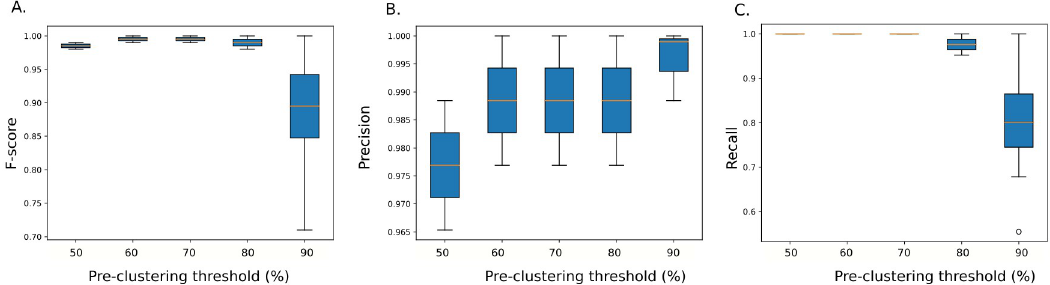
Fig 4. Effect of pre-clustering threshold on MobiLLe’s performance. The pre-clustering threshold varied from 50% to 90%. We computed the closeness F-score (A), precision (B), and recall (C) distribution by considering all simulated repertoires (53760 parameter